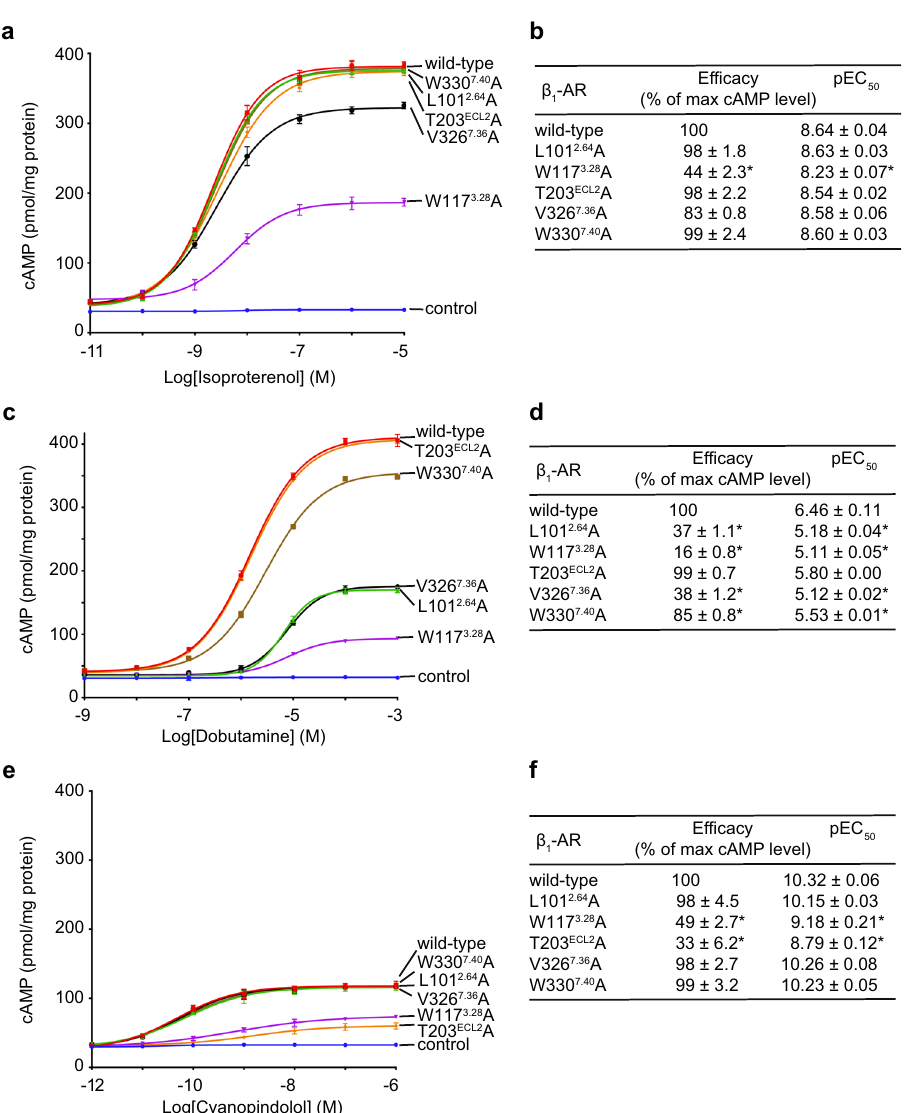
Fig. 3 Functional studies of receptor residues involved in speci fi c interactions with the different ligands. a , b Effects of receptor mutations on isoproterenol-induced cellular cAMP responses. a Dose – response data from cells expressing different β 1 -AR constructs after stimulation with isoproterenol. b Summary of the ef fi cacy (the maximum cAMP level of a mutant receptor / the maximum cAMP level of the wild-type receptor) and the potency (EC 50 values) based on the cAMP assay data shown in ( a ). c , d Effects of receptor mutations on dobutamine-induced cAMP responses. ( c ) Dose – response data from cells expressing different β 1 -ARs after stimulation with dobutamine. ( d ) Summary of the ef fi cacy and EC 50 values based on the cAMP assay data shown in ( c ). ( e , f ) Effects of mutations on cyanopindolol-induced cAMP responses. ( e ) Dose – response data from cells expressing different β 1 -ARs after stimulation with cyanopindolol. f Summary of the ef fi cacy and EC 50 values based on the cAMP assay data shown in ( e ). Data are shown as mean ± SD of three experiments. The analysis was done using the log(agonist) vs. response function of Prism 8 (GraphPad). Statistical analysis was used to compare individual mutant receptors with the wild-type receptor. * p < 0.05 (Student ’ s t -test, two-sided). Source data are provided as a Source Data fi